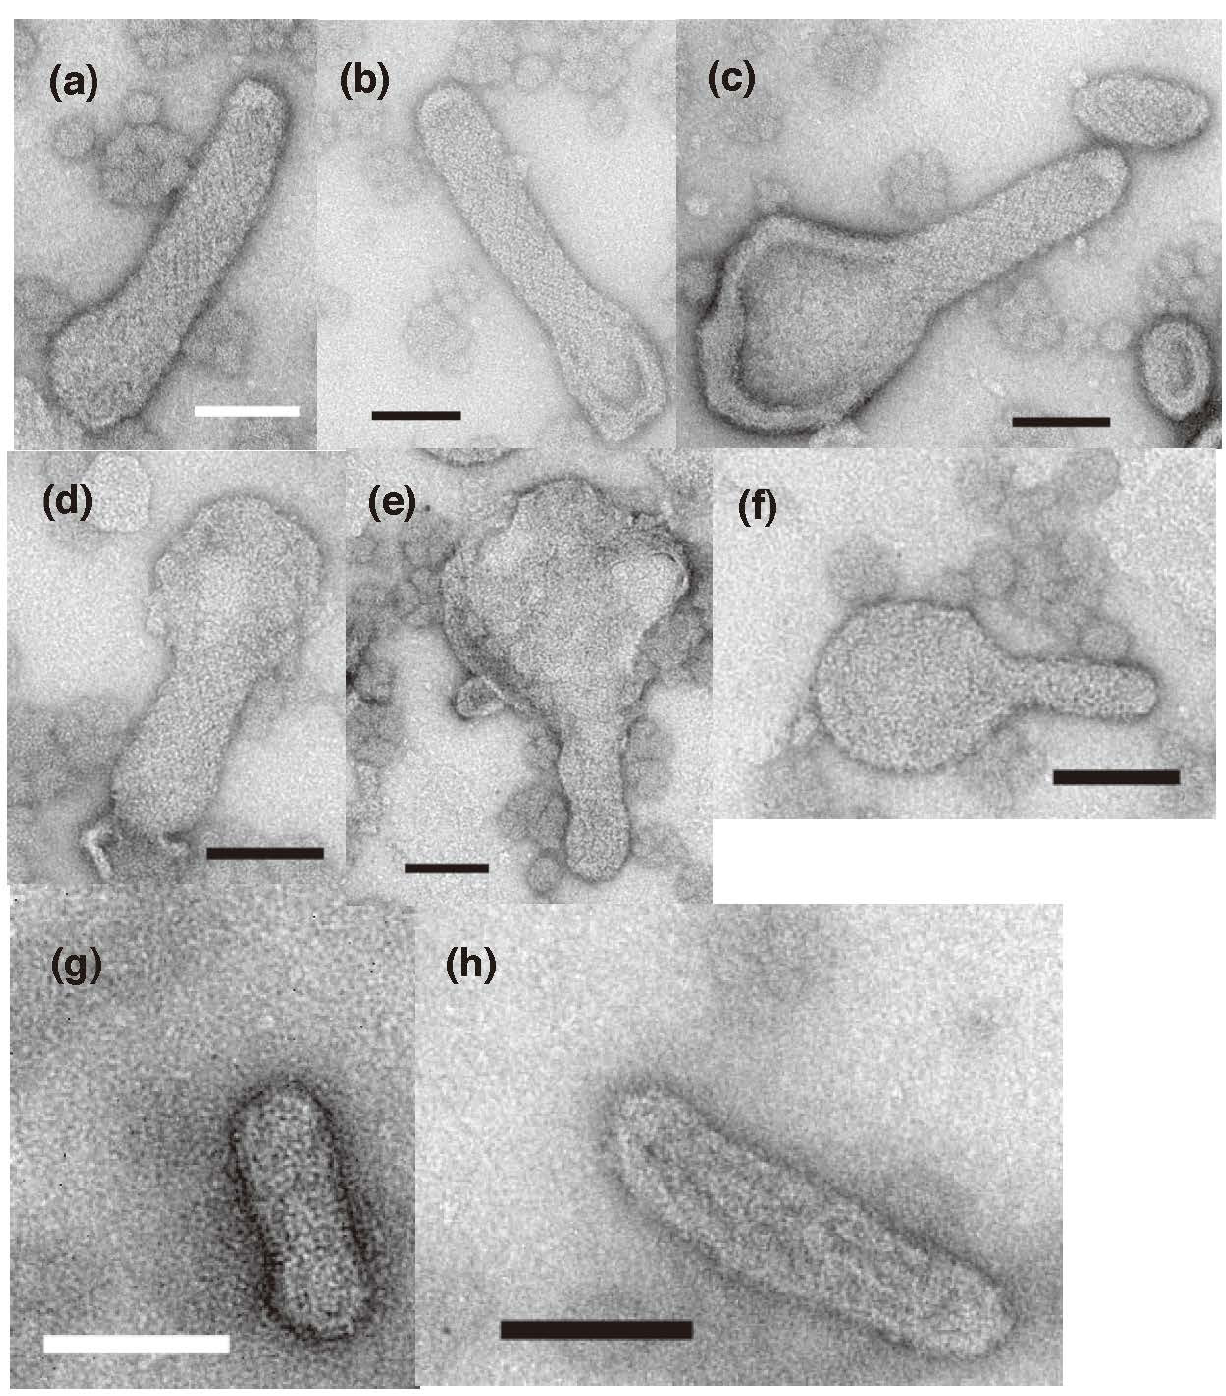
Figure 8. Time course of the morphology of SR vesicles during incubation at a low calcium concentration (~0.002 µM) in the absence of ATP. ( a – c ) SR vesicles after a 37-min incubation. ( d – f ) SR vesicles after 93 min. ( g , h ) SR vesicles after overnight incubation. Orderly arrays were degraded after 93 min and had disappeared after overnight incubation. The incubation was started by the addition of water. Before the addition of water, the SR preparation was incubated in the buffer solution for 5–9 min (see “Section 4. Materials and Methods”). Scale bar: 100 nm.